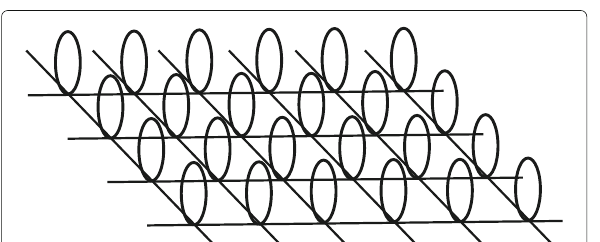
Fig. 2 Fibering structure of the simple cubic lattice. The fibering structure is given as an infinite graph with